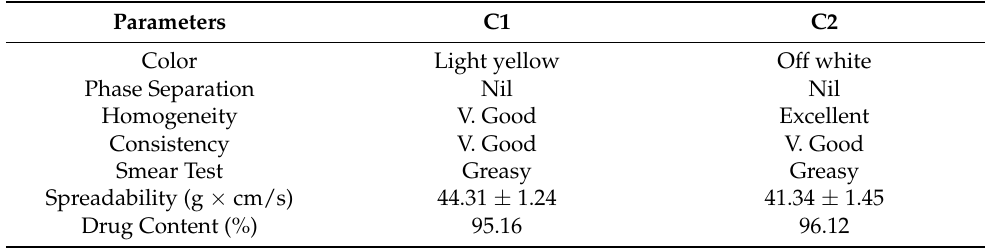
Table 3. Physical appearance of prepared